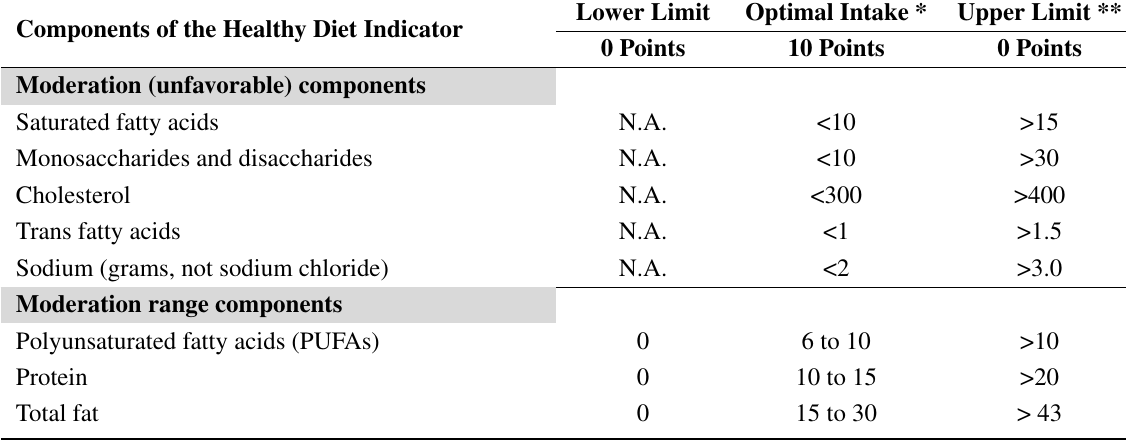
Table 1. Cut-offs used for computation of the Healthy Diet Indicator (HDI) (Jankovic, 2014 [7],